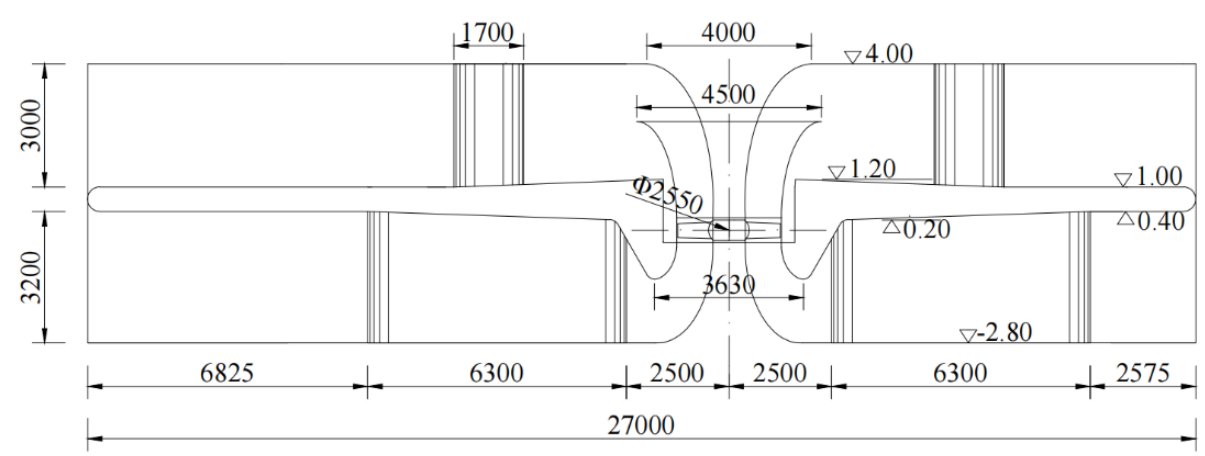
Figure 4. Cross-sectional view of the full flow path of the pumping station.